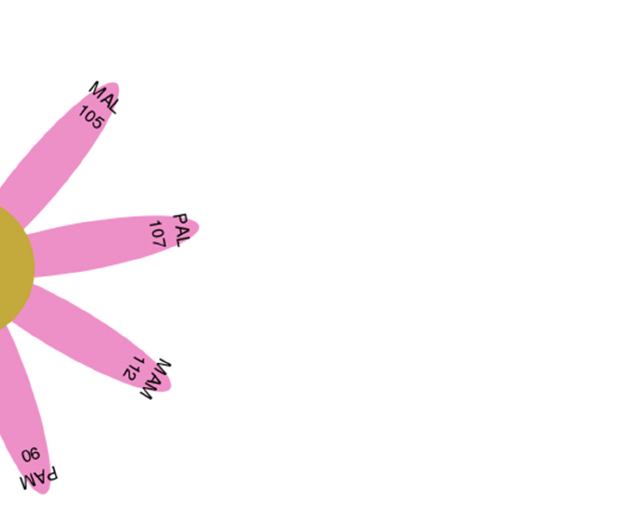
Figure 2. Venn diagram of OTU distribution. C is a sample of Cabernet Sauvignon, M is a sample of Matheran, and P is a sample of Cabernet Franc.